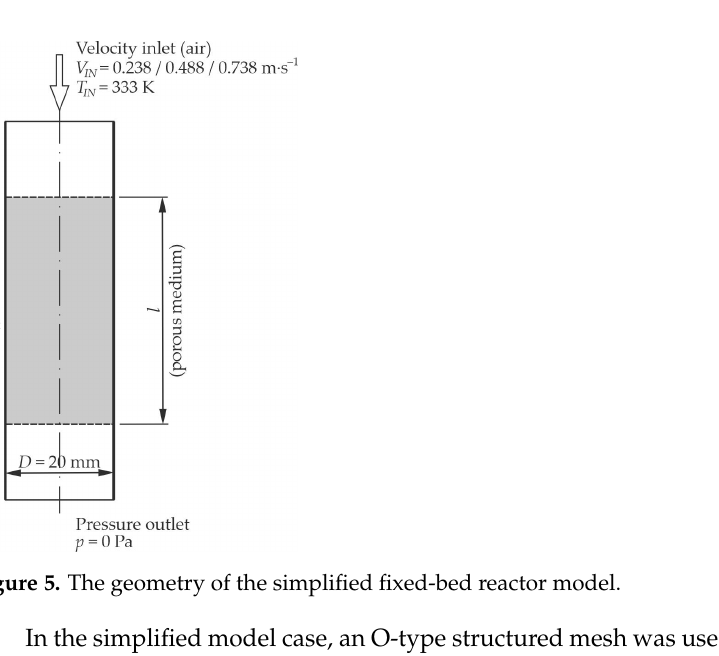
Figure 7. Cross-section of the computational mesh in the porous medium zone. All simulations (including the meshindependence tests) were performed using the commercial ANSYS Fluent 18 software (ANSYS Inc., Canonsburg, PA, USA). The realizable k-ε turbulence model was selected, and the boundary conditions were set as shown in Figures1 and 5. 3. Results and Discussion 3.1. Detailed Geometry Model Results A series of simulations were performed in order to get the output values of pressure drops and heat exchanges within the bed. For each geometry variant, three simulations were carried out at different inlet air velocities (0.238, 0.488, and 0.738m/s). An example of the results is shown in Figure 8. ( a ) ( b ) ( c ) Figure 8. Example of simulation results for the reactor with 13 layers of spheres with a diameter of 3 mm, showing distributions of:( a ) velocity, ( b ) pressure, ( c ) and temperature.